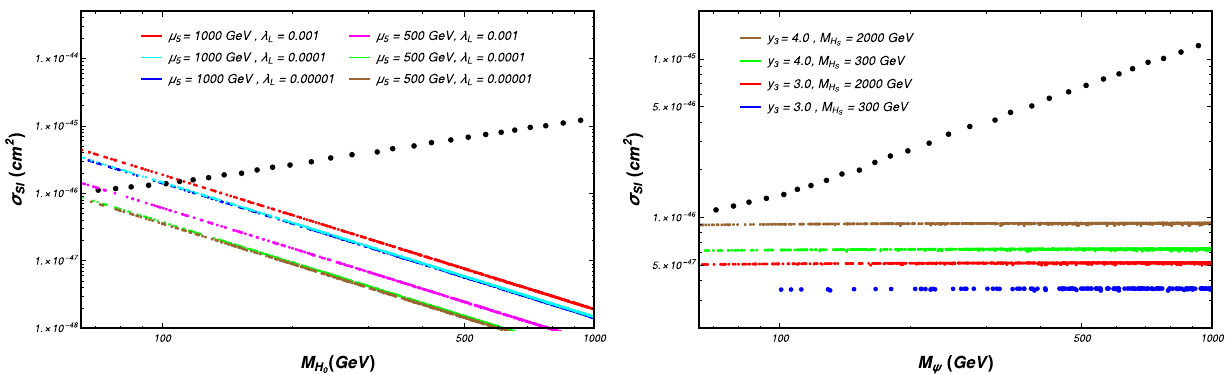
Fig. 3 σ SI vs M DM for different couplings and mediator mass relevant to direction detection processes. The black dotted lines represent the current XENON IT bound [40] ≥ 65 GeV, and μ ≤ 1000 GeV is ble with M H 5 0